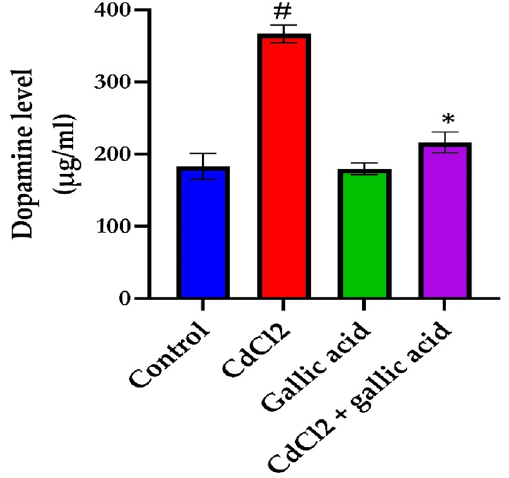
Figure 4. Gallic acid reverses the levels of dopamine in the cerebrum of rats administered with distilled water, CdCl 2 alone, gallic acid alone, and CdCl 2 + gallic acid (20 mg/kg). The data is represented as mean ± SD (n = 5). # Significant at p < 0.05 compared to the control; *Significant at p < 0.05 compared to the CdCl